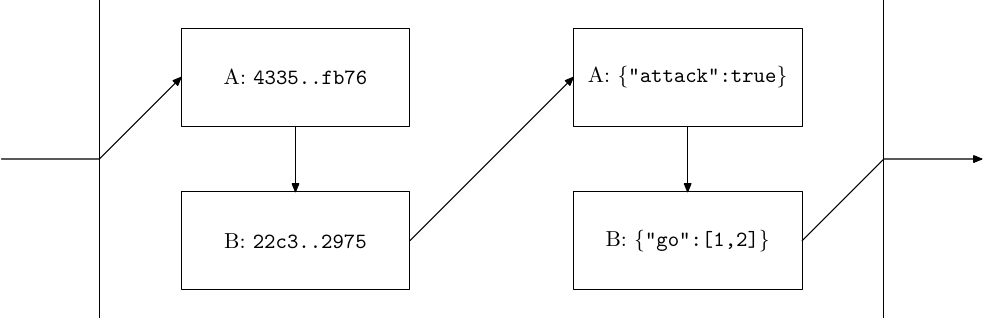
Fig. 4. Illustration of a single shared turn that is made up from four micro-turns alternating between Alice and Bob. The hash commitment is computed using